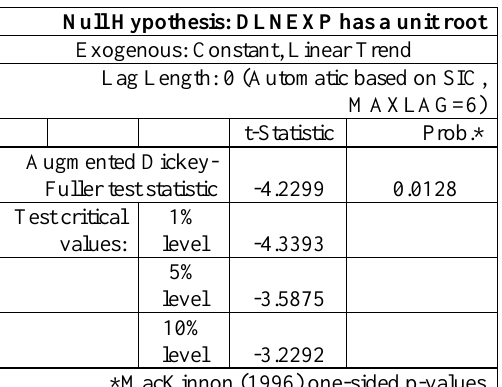
Table 1: ADF Test for exports